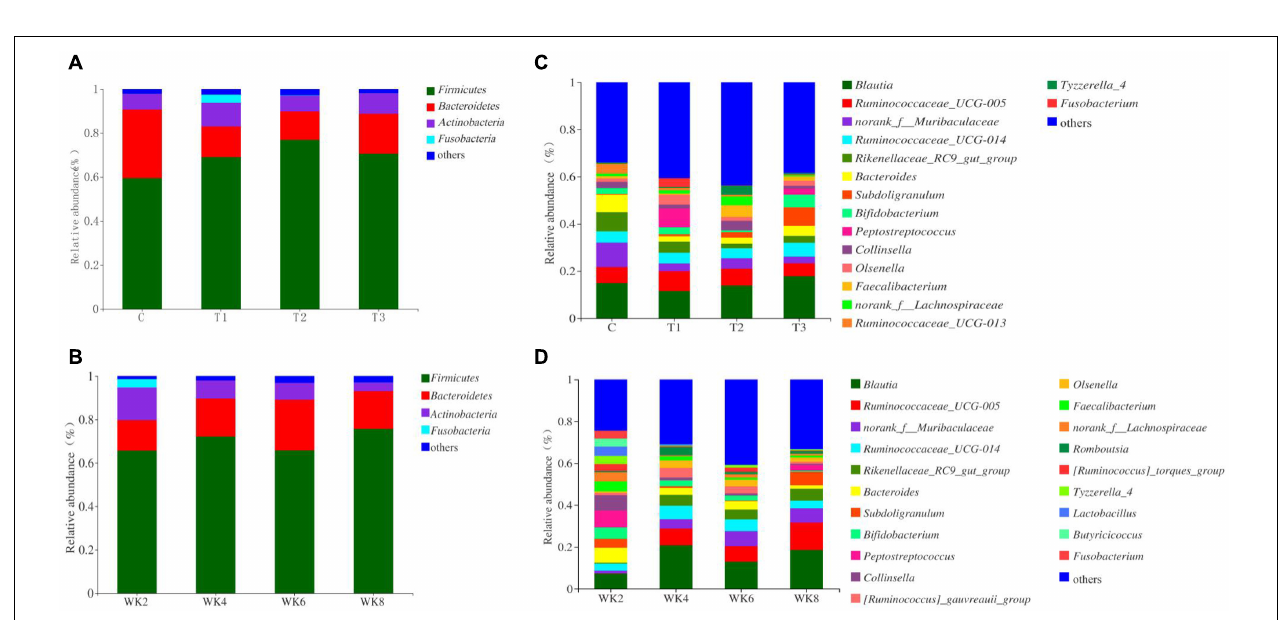
FIGURE 3 | Composition of the fecal microbial community. Panels (A,B) show the composition of the microbial community in the four groups (C, T1, T2, and T3) with respect to the phyla and genera of bacterial. Panels (C,D) show the compositions at four time points during the study (WK 2, 4, 6, and 8).